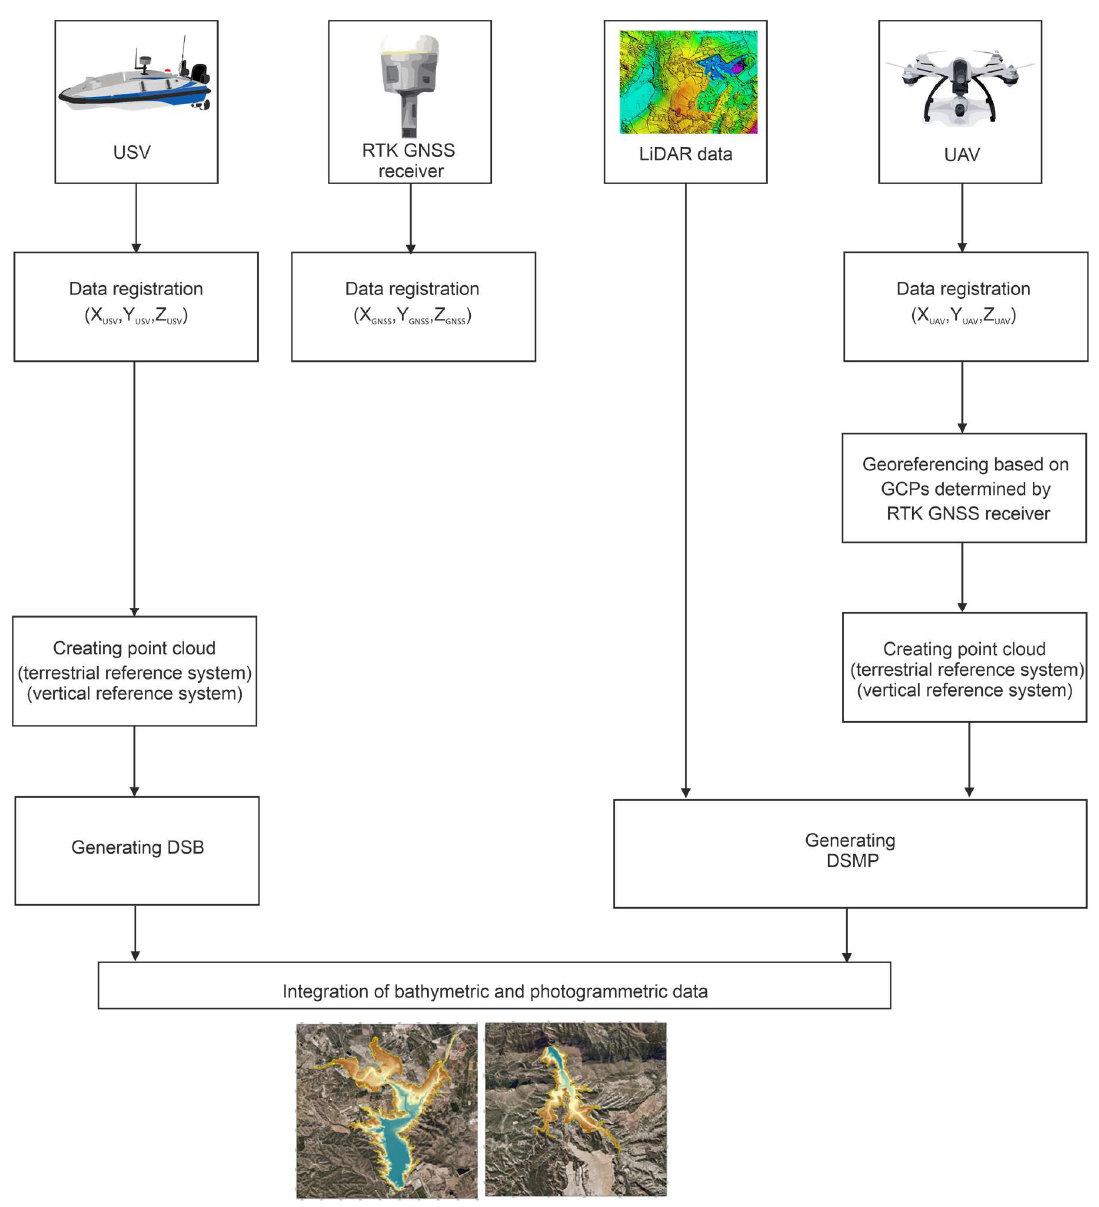
Figure 3 Figure 3. A simplified block diagram presenting the GNSS, TLS, UAV and USV data integration according to